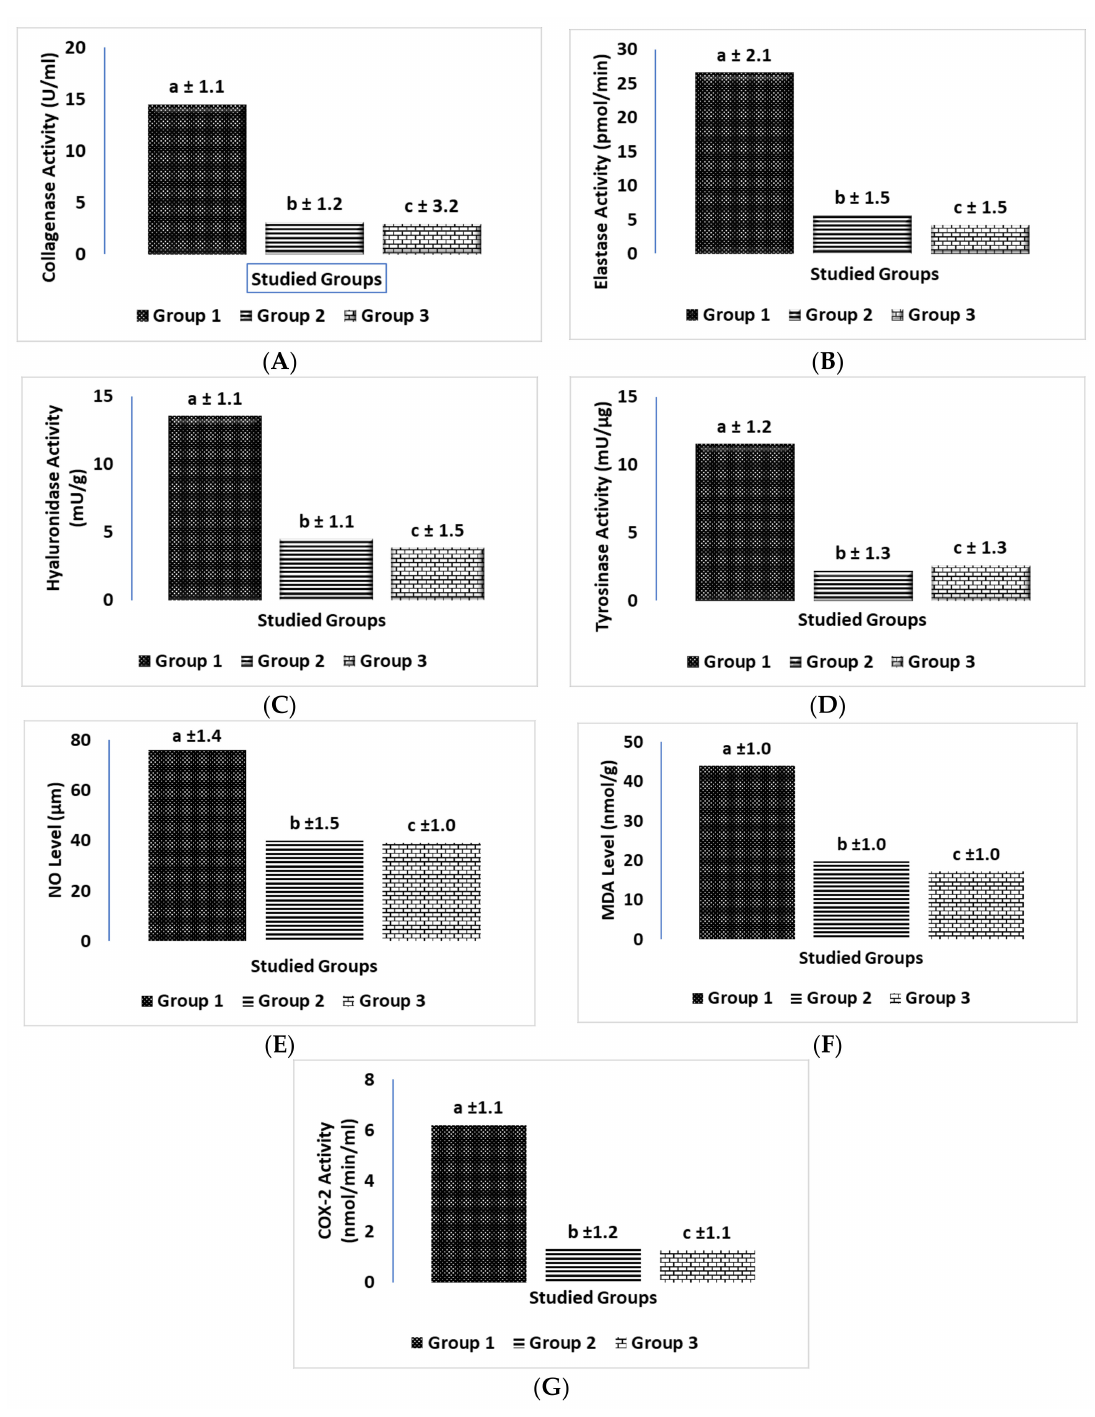
Figure 4. Biochemical comparison of the three groups in human skin investigation. ( A ) Collagenase; ( B ) elastase; ( C ) hyaluronidase; ( D ) tyrosinase; ( E ) nitric oxide (NO); ( F ) malondialdehyde